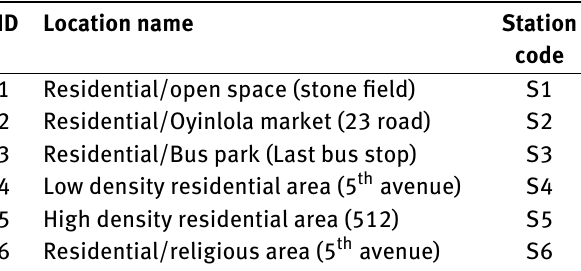
Table 1: Observation stations and